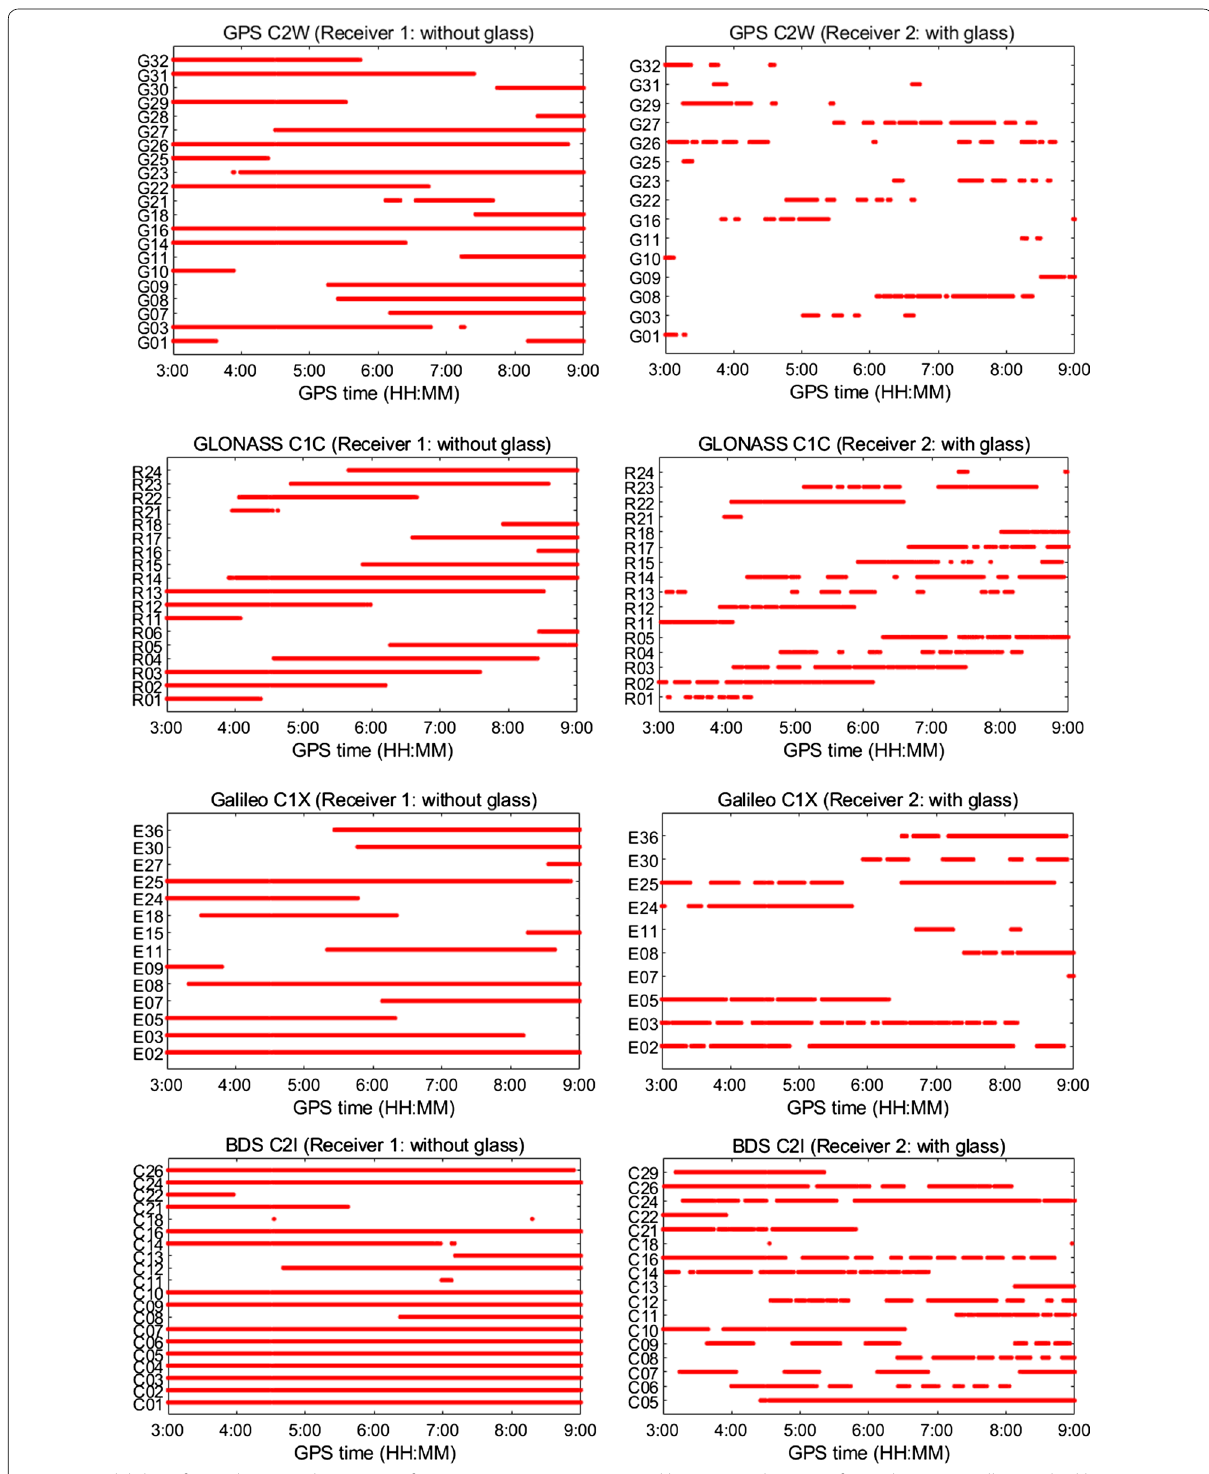
Fig. 2 Availability of pseudorange observations for GPS C2W, GLONASS C1C, Galileo C1X, and BDS C2I for each GNSS satellite tracked by receiver 1 (left column, without HST window glass) and receiver 2 (right column, with HST window glass) deployed on a building rooftop on the campus